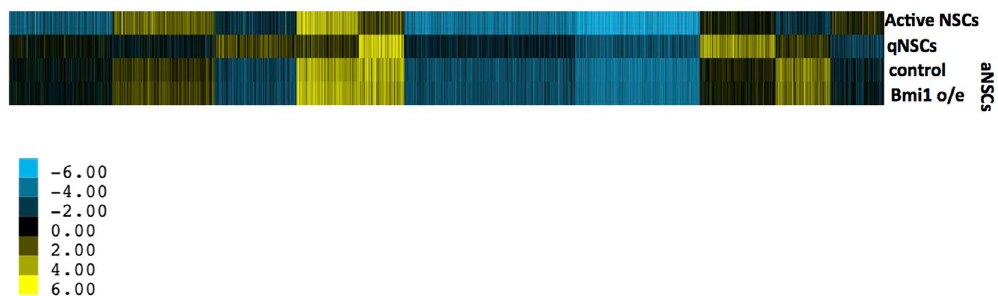
Figure 2. K-means clustering of gene expression in active and quiescent NSCs and aNSCs. K-means clustering (K = 10) of gene expression for active and quiescent aNSCs 32 , and for control and Bmi1-overexpressing aNSCs, was performed using genes that exhibited at least four-fold change in expression between active and quiescent adult NSCs. Expression values from microarray analyses were adjusted by subtraction of the mean value to allow values to center around zero. Genes belonging to the 10 clusters are listed in Supplementary Table